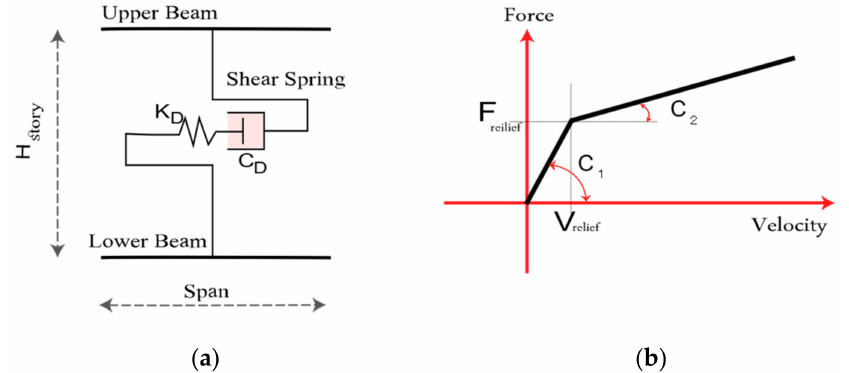
Figure 8. ( a ) Element model of bilinear-type oil damper, ( b ) force–velocity of oil